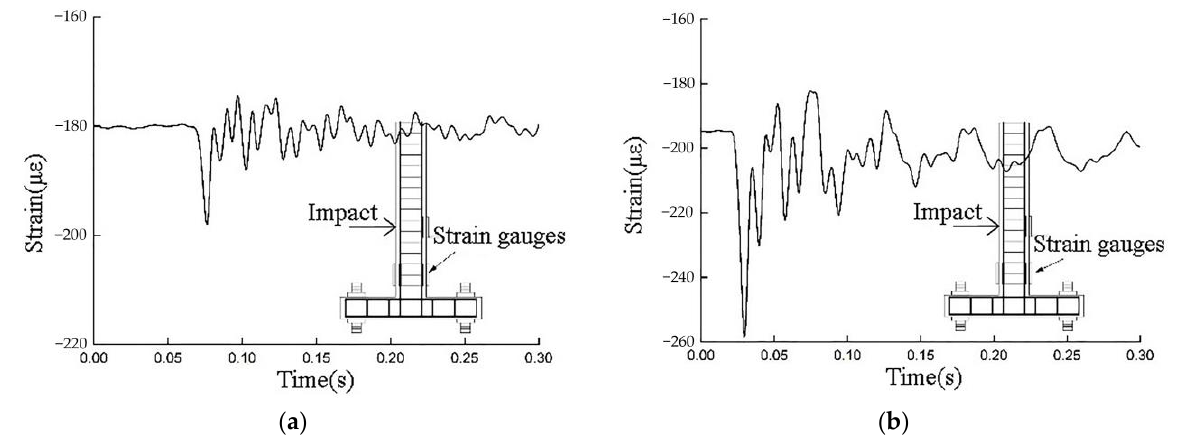
Figure 12. Strain time history of concrete of C_3 when axial compression ratio was 0.2: ( a ) drop height = 30 cm and ( b ) drop height = 200 cm.